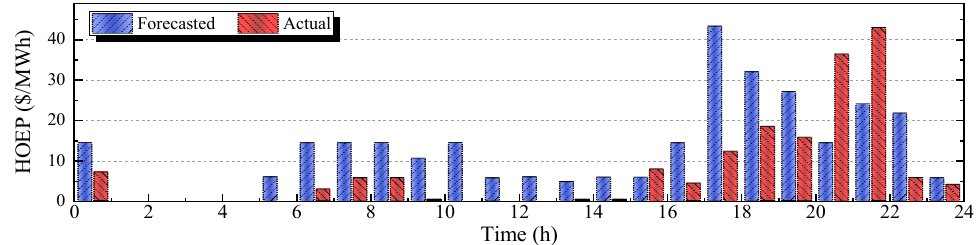
Figure 1. Forecasted and actual hourly Ontario energy price (HOEPs) on 23 December 2016.